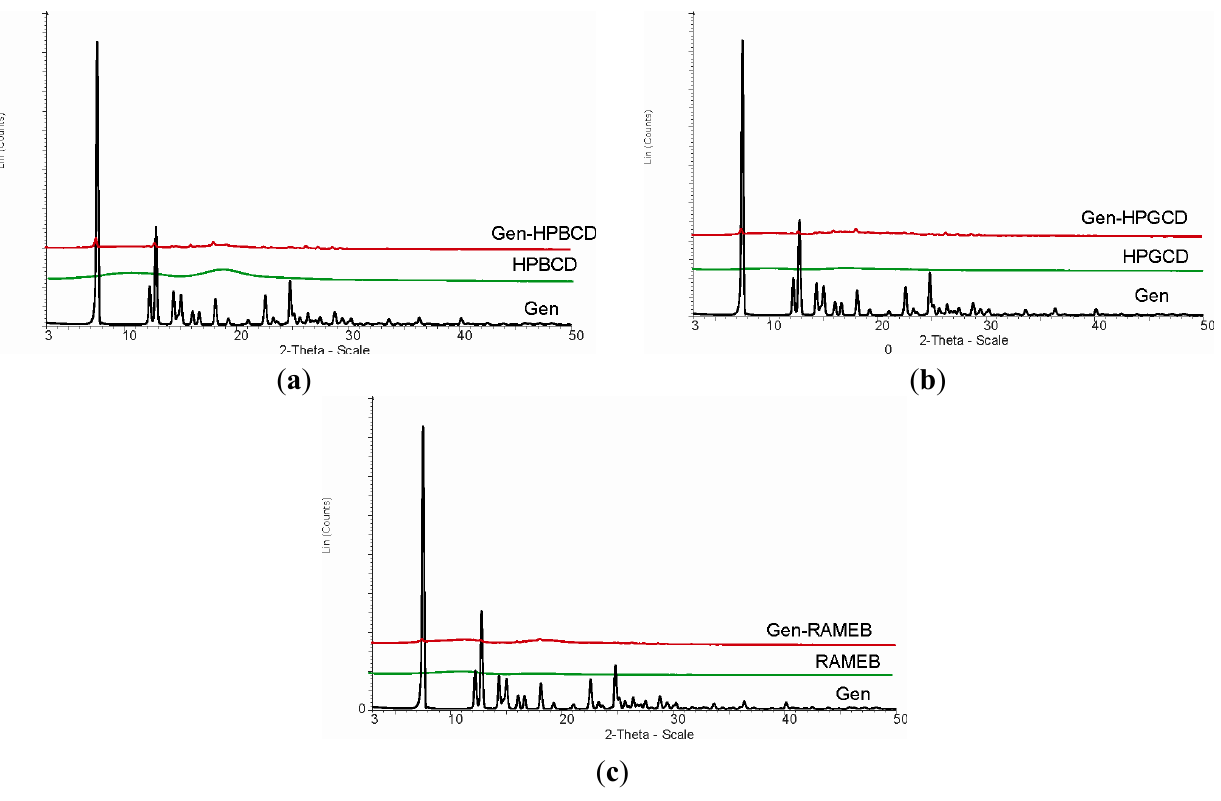
Figure 3. X-ray diffractograms for Gen and its 1:1 complexes as follows: